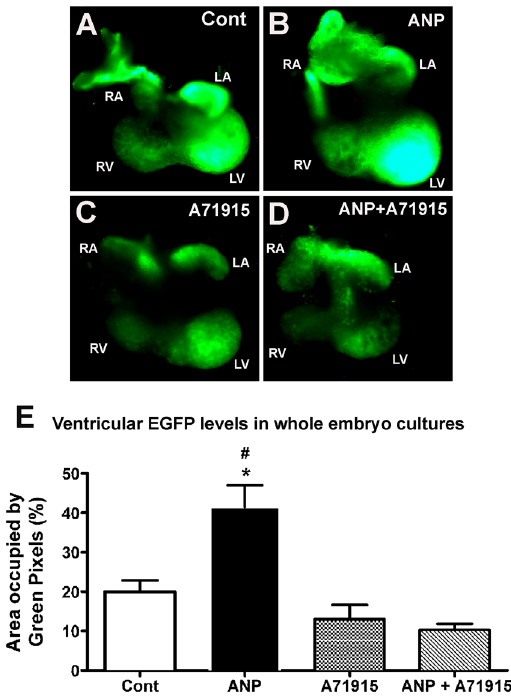
Figure 4. The effects of exogenous ANP and A71915 on EGFP reporter fluorescence in whole embryo cultures derived from Cx40 egfp mice. ( A – D ) At E10.5, Cx40 egfp/ + whole embryos were cultured in the presence or absence of ANP (1 μ g/ml) and/or A71915 (1 µ M) for 24 hours. After 24 hours, whole hearts were isolated at E11.5 stage and reporter gene expression was visualized. ANP-treated whole hearts had strong EGFP signals in both atria and ventricles, with the strongest signal coming from the left ventricle. A71915-treated hearts and combination-treatment hearts showed weaker EGFP signals in all four chambers of the heart. RA: right atrium, RV: right ventricle, LA: left atrium, LV: left ventricle and OFT: outflow tract. ( E ) Quantification of green pixels (%) to determine reporter gene expression in Cx40 egfp + / − ventricles at E11.5 treated with ANP and/or A71915. N = 5 hearts per group. Each bar represents mean ± SEM. * P < 0.05 Vs. Cont, # P < 0.005 Vs. A71915 or ANP + A71915. One-way ANOVA with Tukey post hoc